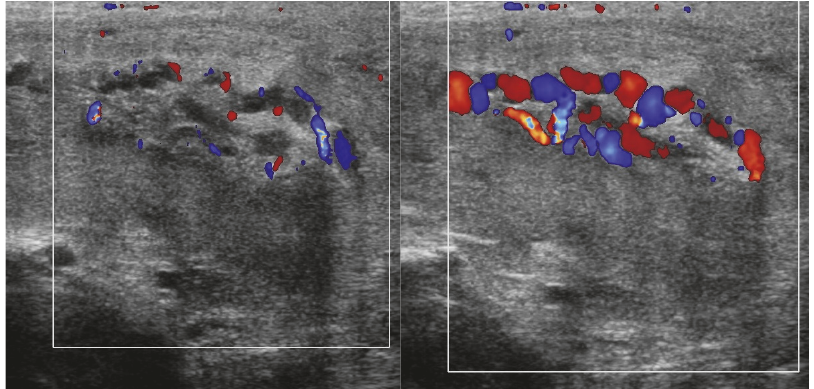
Figure 2: Doppler ultrasonography: dilatation of the pampiniform plexus of veins, image compatible with the varicocele.